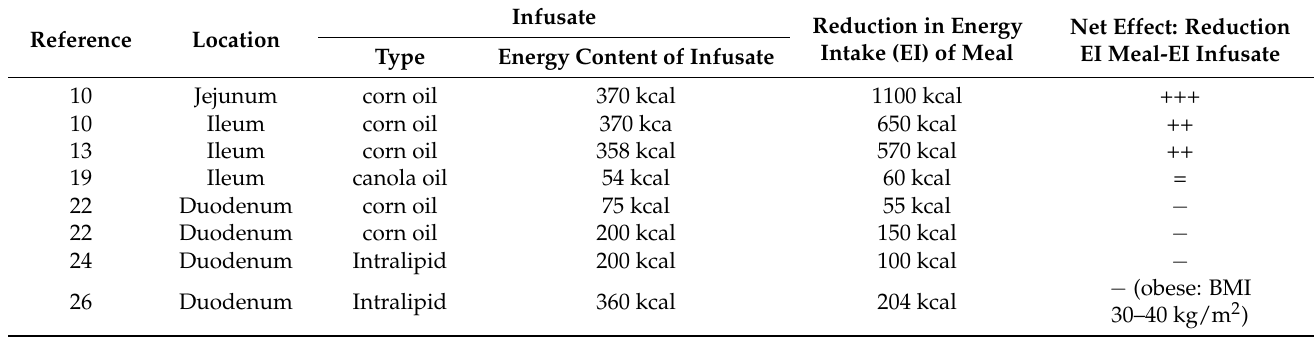
Table A1. Net effect of infusion of fat or fatty acids into duodenum, jejunum or ileum on energy intake, taking into account the reduction in energy intake of meal minus energy content of the